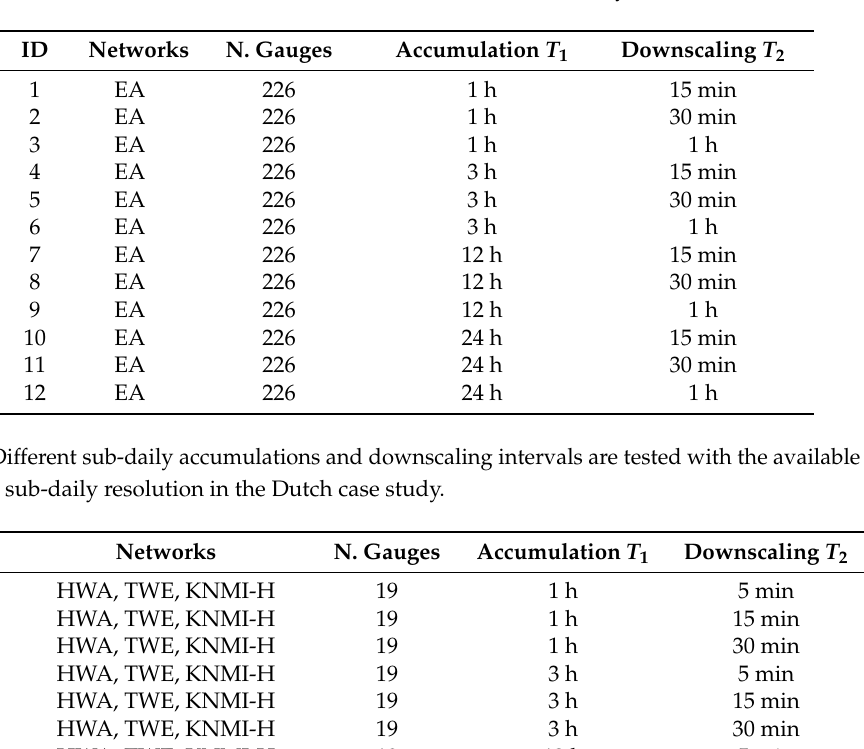
Table 2. Products tested in the UK case study.